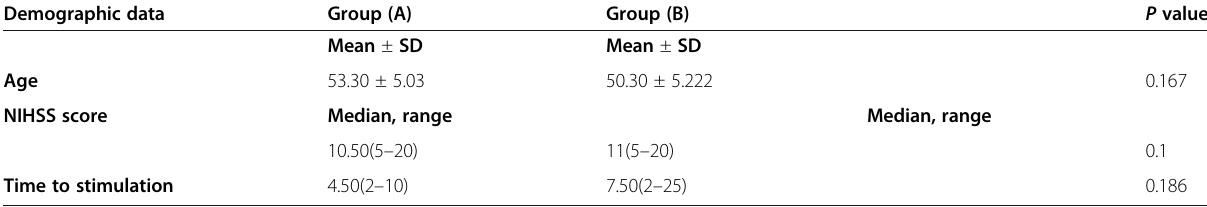
Table 1 Comparison between groups A and B for age, NIHSS score, and time of stimulation Demographic